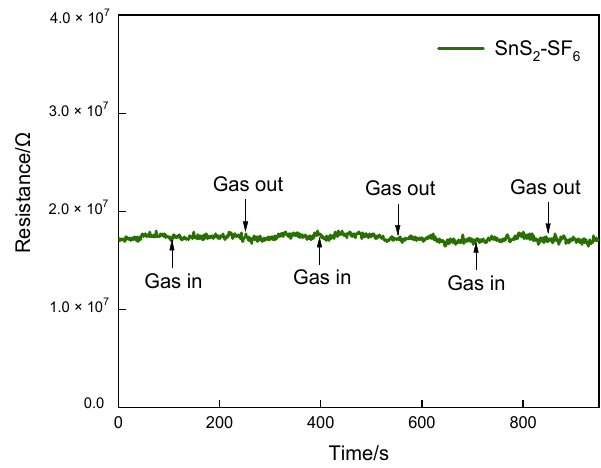
Figure 8. The response curve of the SnS 2 sensor to SF 6 .